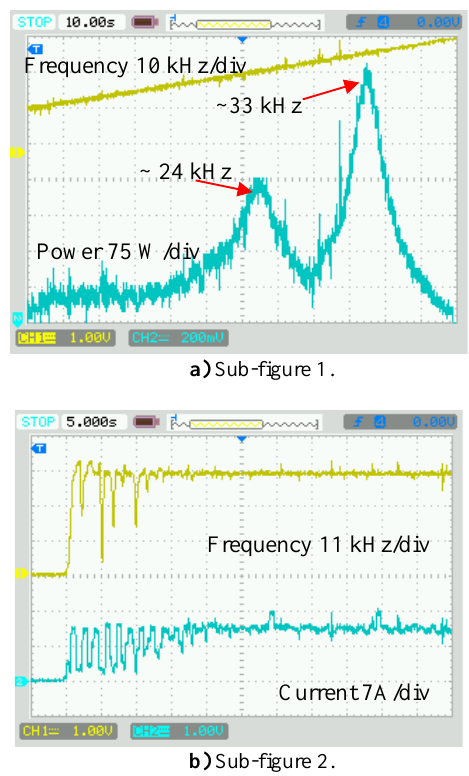
Figure 11. Oscilloscope screenshot for Scenario III for scanning for input power to the primary side resonant coupler and the inverter’s switching frequency (a) and performance of PSO algorithm (b).